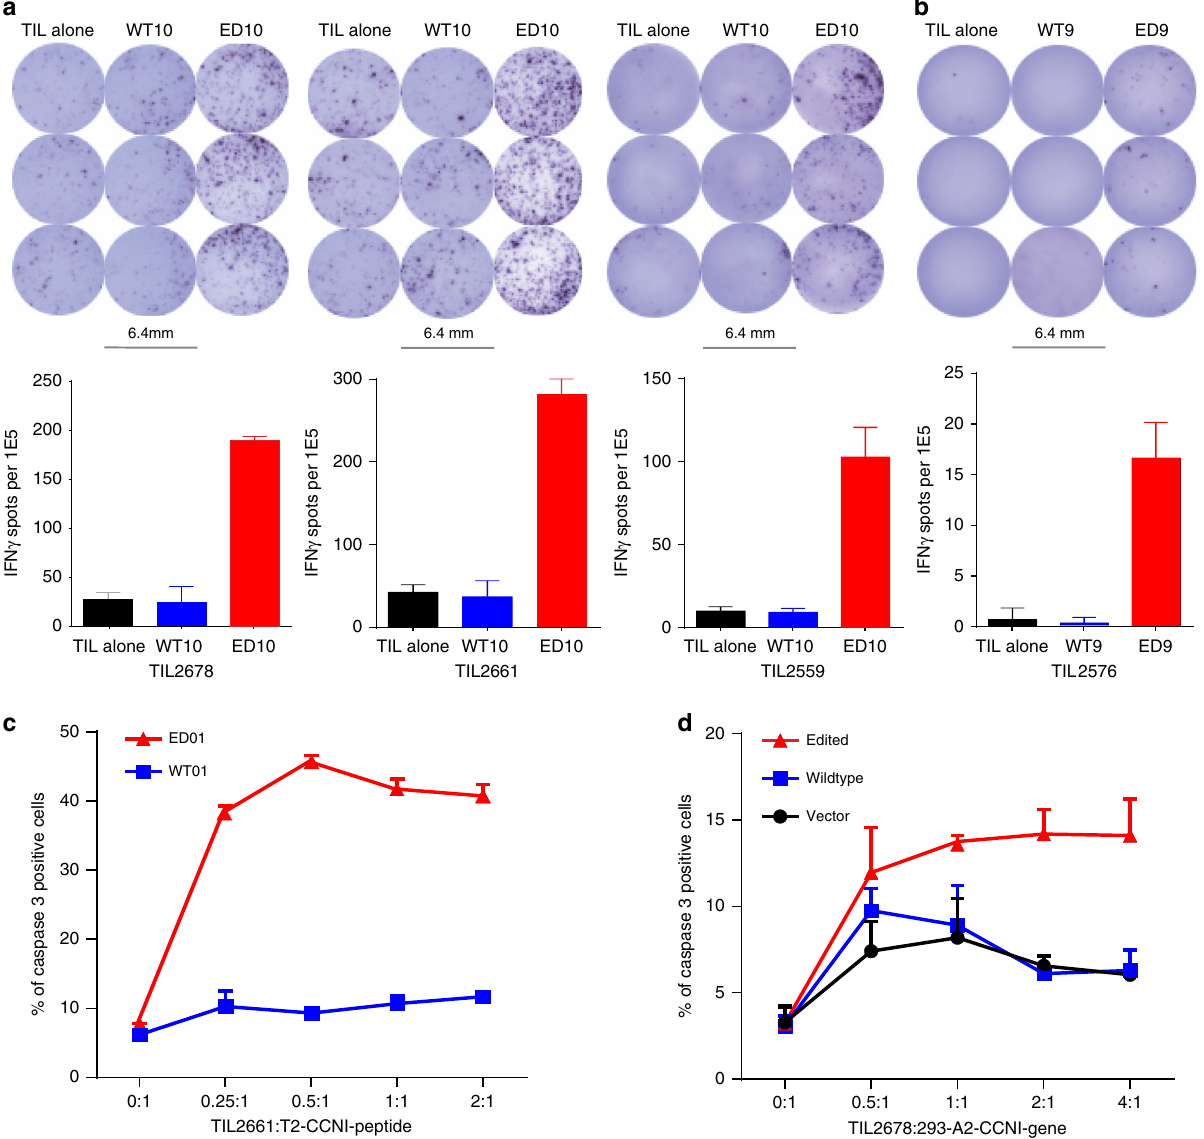
Fig. 2 Response of TILs to CCNI peptides. a ELISPOT (upper) and summary graphs (lower) showing IFN γ production (arithmetic mean and s.e.m., n = 3) by 3 melanoma TILs following incubation with CCNI-ED10 peptide. Only background level of IFN γ -producing TILs were detected when incubated alone or together with CCNI-WT10. b TIL2576 weakly reacted to CCNI-ED9. c Caspase3 based Cytotoxic T Lymphocyte (CTL) killing assay showing TIL2661 mediated killing of T2 cells pulsed with CCNI-ED10 or CCNI-WT. d Overexpression of edited but not wildtype CCNI gene in 293-A2 cells enhanced TIL2678 ’ s CTL killing activity. The error bar represents the standard error of the mean (s.e.m.) of the three